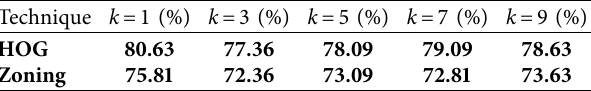
Figure 7: Training data vs. accuracy.